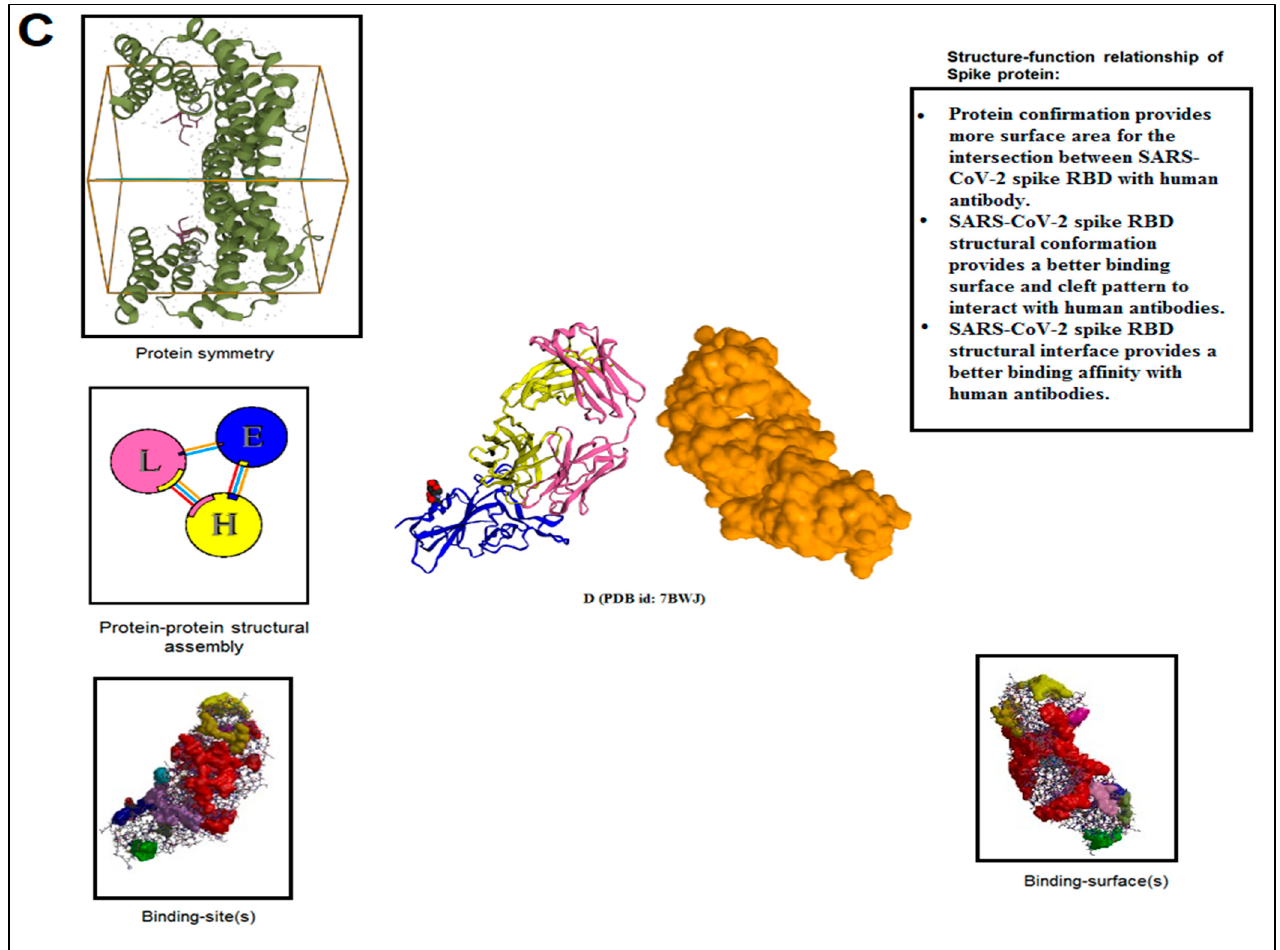
Figure 10. The post-processing and decision-making of the study finally tried to capture the structure–function relationship of the SARS-CoV-2 proteins and non-SARS-CoV-2 proteins. We have represented two examples from the study. ( A ) The figure illustrated the structure–function relationship of the protein alphabet ‘C’ (PDB ID: 6XC3). It is a SARS-CoV-2 S-glycoprotein. ( B ) The figure represented the structure–function relationship of the protein alphabet ‘S’ (PDB ID: 7OYG). It is a SARS-CoV-2 RNA-dependent RNA polymerase (RdRp), which is dimeric form. ( C ) The figure represented the structure–function relationship of the protein alphabet ‘D’ (PDB ID: 7BWJ). The structure represents the human nAb (neutralizing antibodies) linked with SARS-CoV-2 RBD.